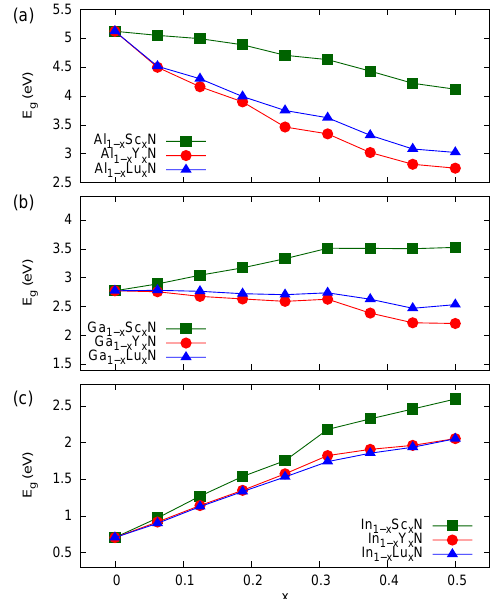
Figure 3. Band gaps calculated (MBJGGA) for wurtzite alloys ( a ) Al 1 − x RE x N, ( b ) Ga 1 − x RE x N, ( c ) In 1 − x RE x N, where RE = Sc, Y, and